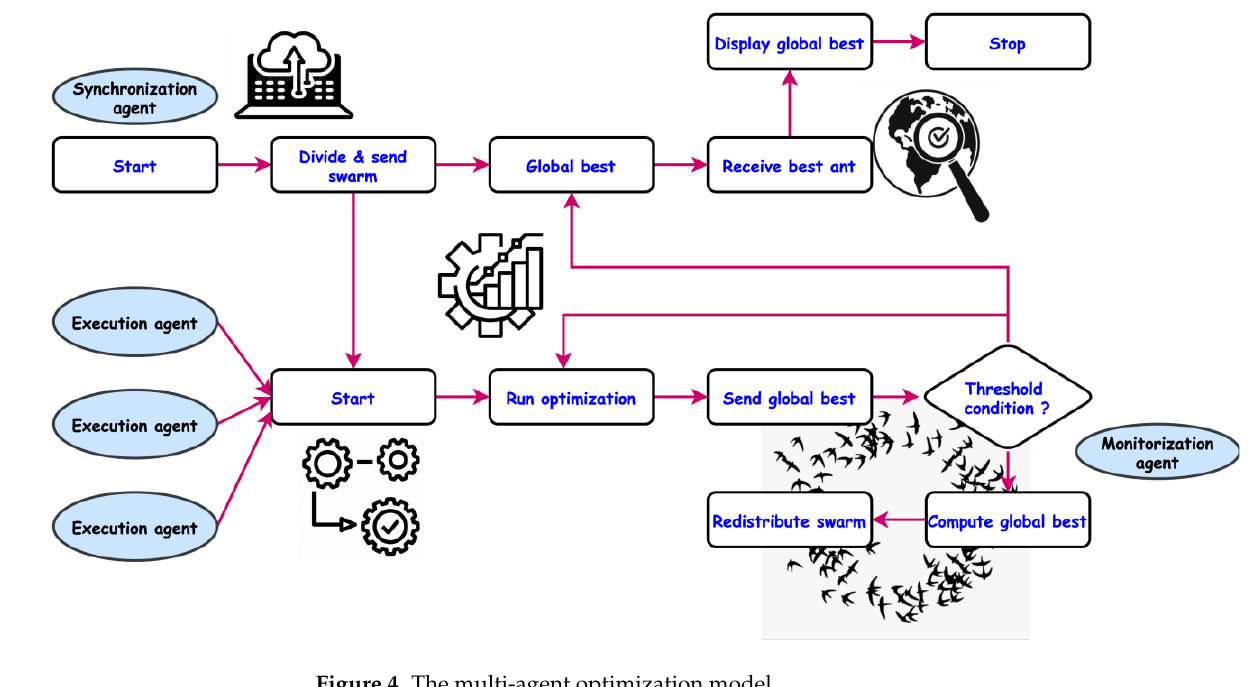
Figure 4. The multi-agent optimization model.